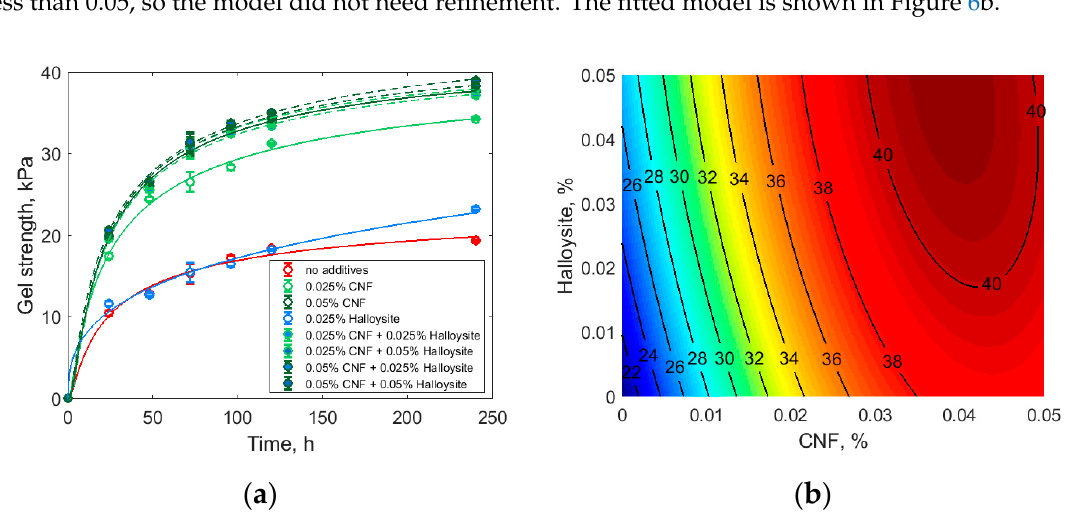
Figure 6. ( a ) Silica gelation with various additives. Lines are Gompertz model fits. ( b ) Gel strength at 240 h (showed by isolines, kPa) as a function of cellulose nanofibrils and halloysite added. CNF: cellulose nanofibrils.